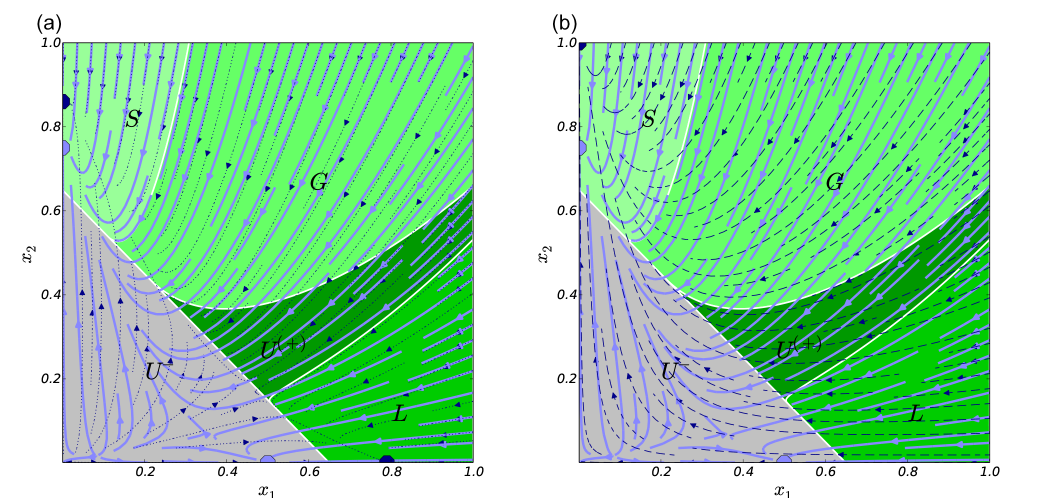
Figure 5. Competing plant types example, showing all upstream regions and illustrating the lake dilemma. A bistable system of two com- peting plant types with two simultaneous management options (depicted in separate plots only for discernibility). Management by a general harvesting quota (dotted arrows shown left) can ensure desirable long-term harvests of the less productive type x 1 ( lake L ). Management by temporary protection of the more productive type x 2 (dashed arrows shown right) can cause a transition to the desirable fixed point (in the shelter S ), but only through the undesired region of low harvests (grey region). The state space partition boundaries resulting from both options together (white curves) and a desirable minimum harvest boundary (white diagonal) follow some admissible trajectory at each point.